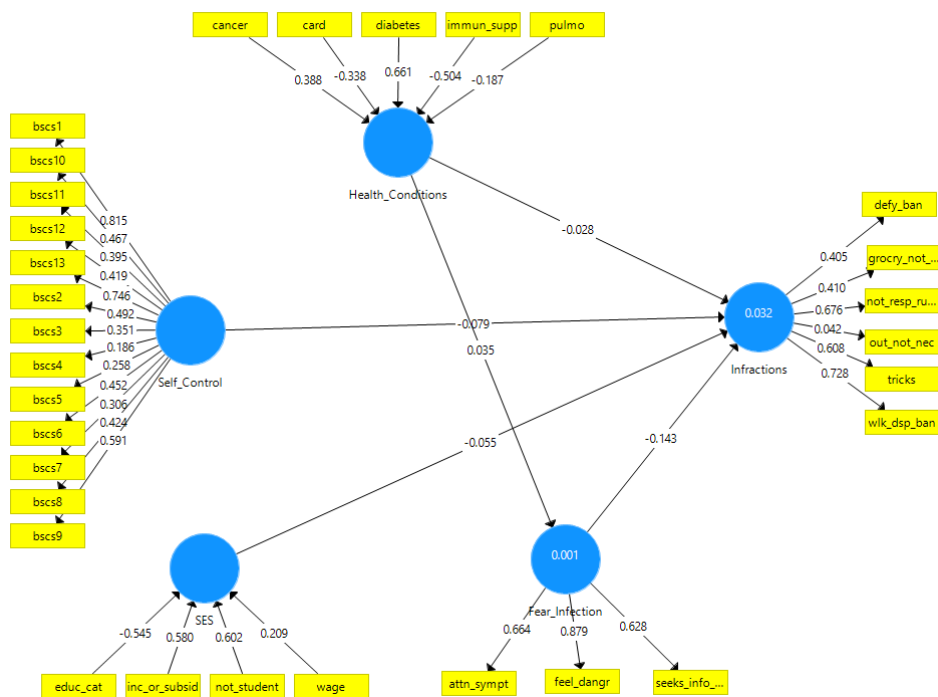
Figure 2. Model 2: Direct Effects + 1 indirect Effect. The same as Model 1 except for an added path (regression coefficient) from health conditions to fear of infection. The indirect effect of health conditions on infractions is not significant.